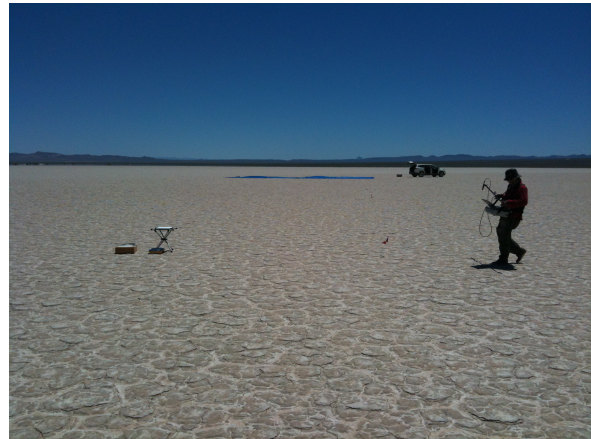
Figure 2. Vicarious calibration experiment in Railroad valley playa (Jun, 2012)